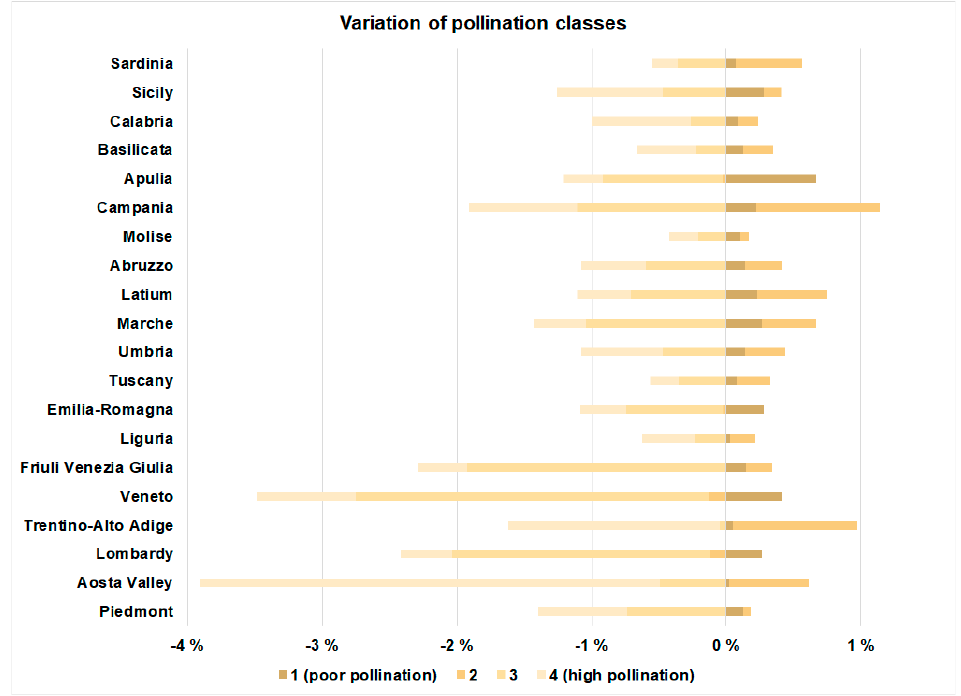
Figure 10. Percentage surface variation of pollination classes due to land consumption in the period 2012–2020 at the regional level.